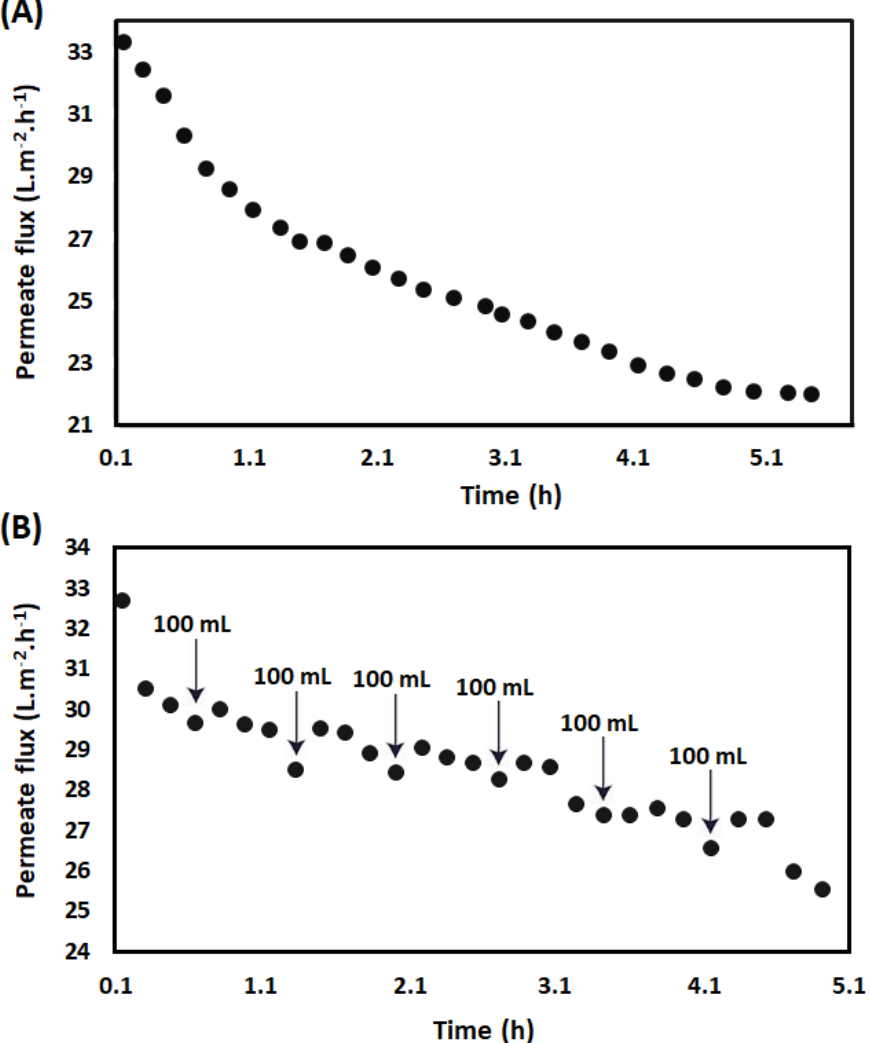
Figure 2. Permeate flux with the filtration time progression, ( A ) without the addition of milk in the feed tank in the intermediate steps of the filtration process, and ( B ) with the addition of milk in the feed tank in the intermediate steps of the filtration process.